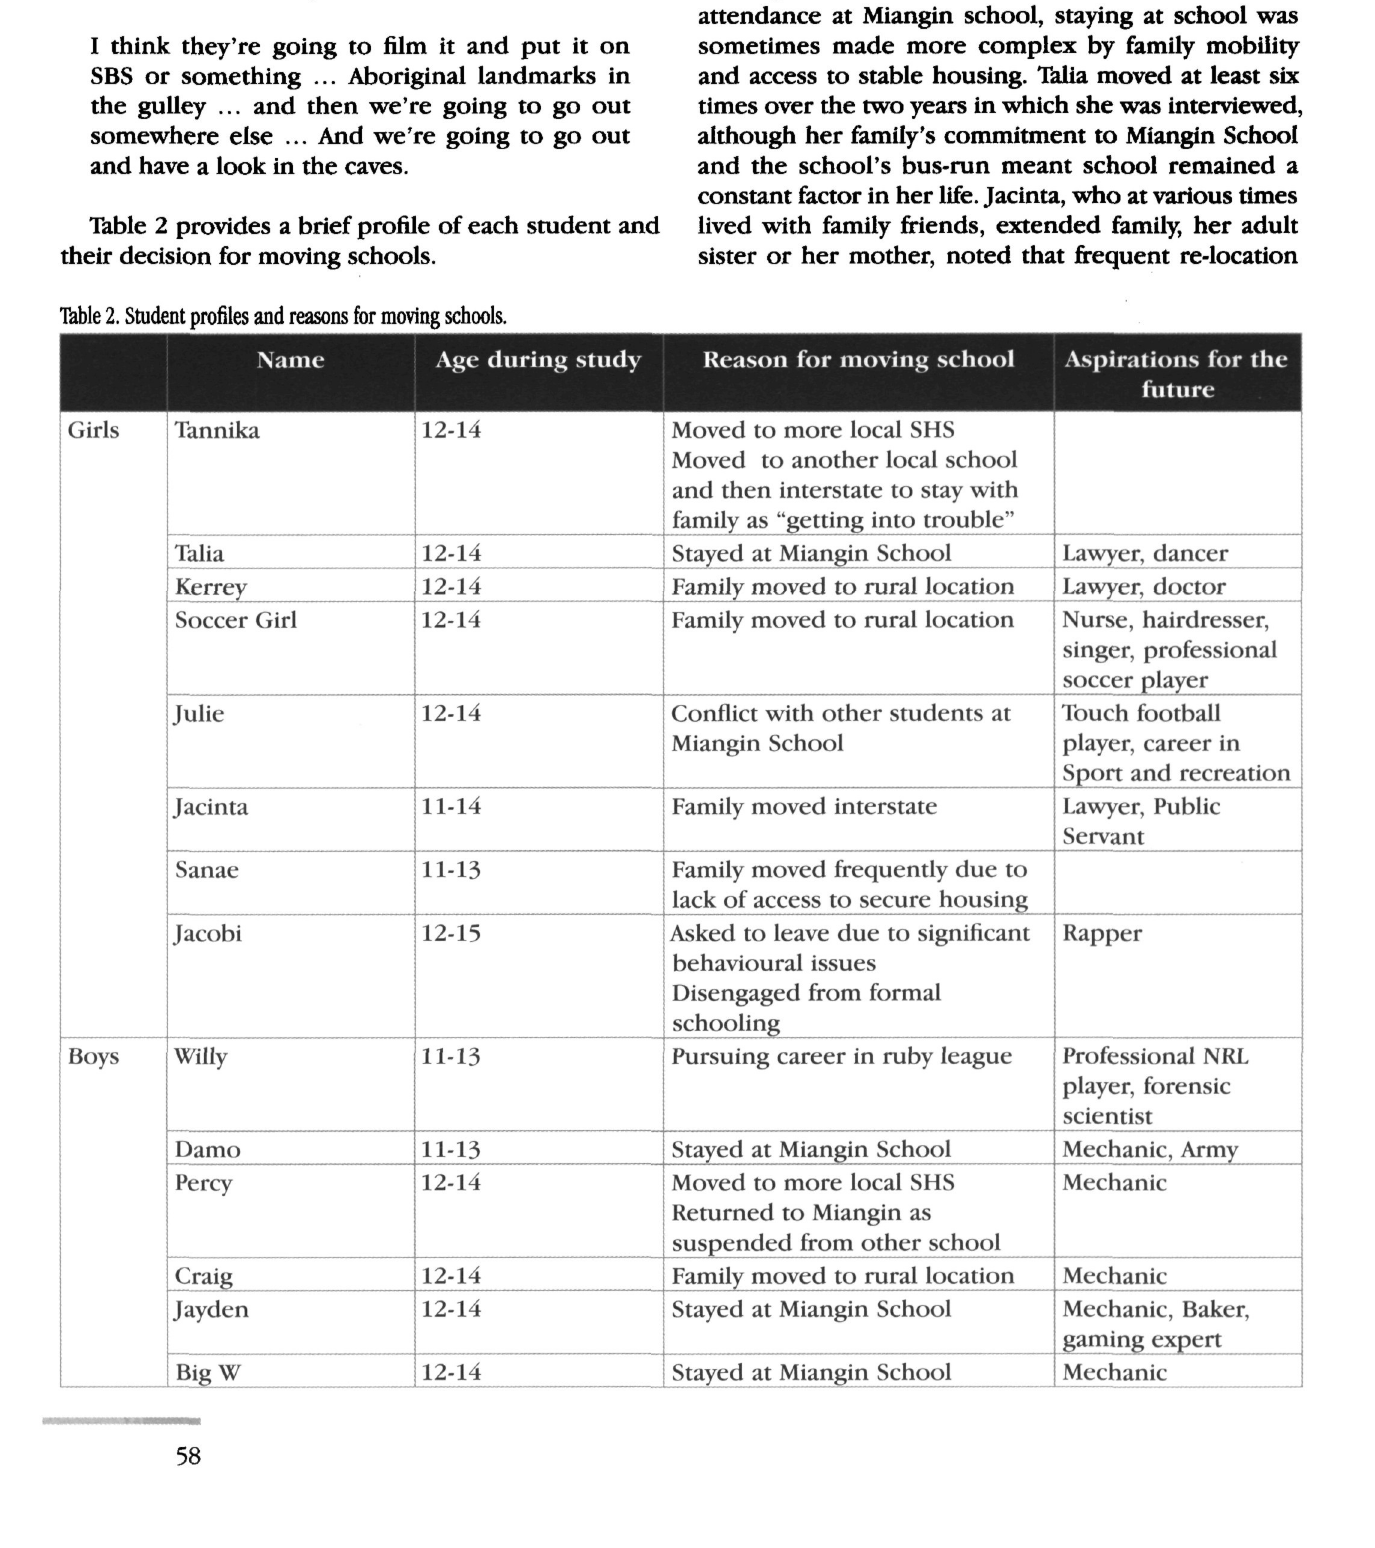
Table 2. Student profiles and reasons for moving